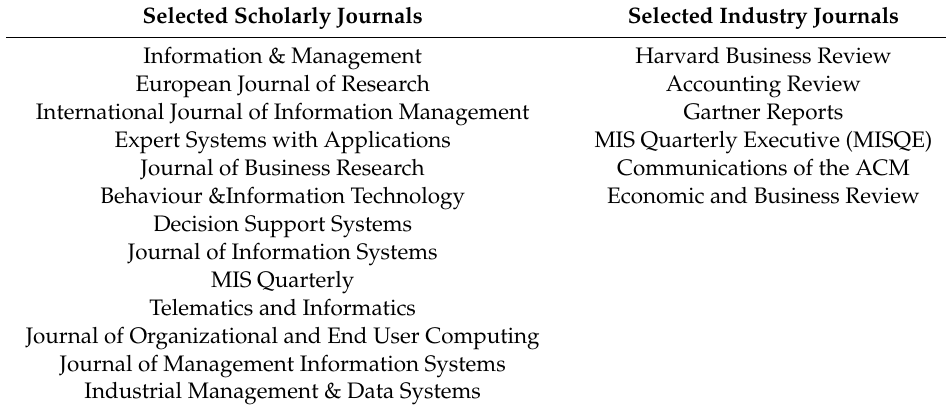
Table 3. Journals